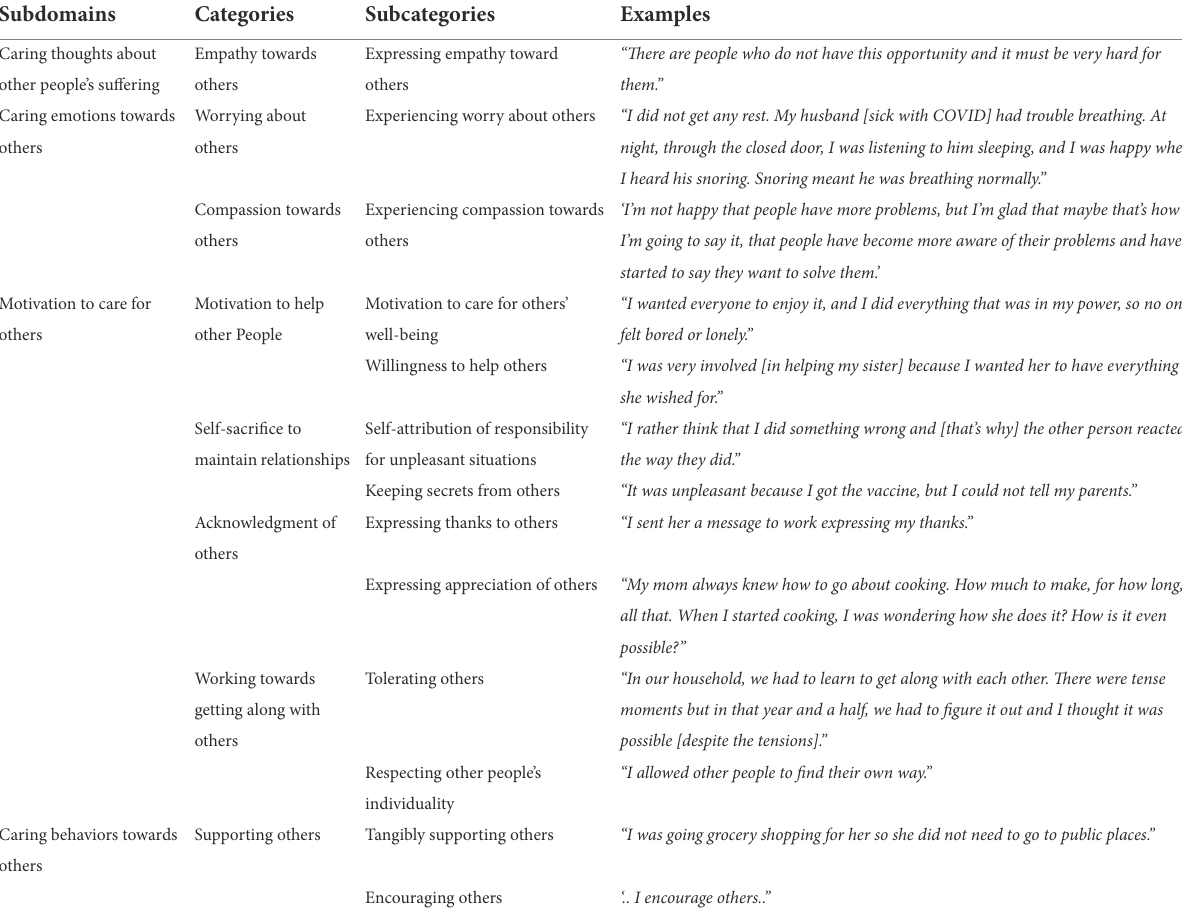
TABLE 2 Categorization of the domain Compassion to